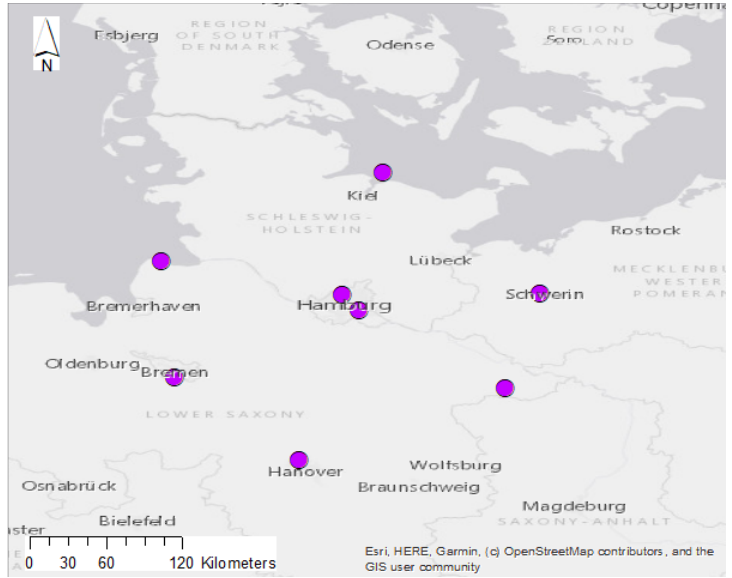
Figure A2. Map showing the locations of the virtual weather stations. The meteorological data extracted from the DWD forecast at the eight virtual weather stations were used as input to the meteorological pre-processor MCWIND.